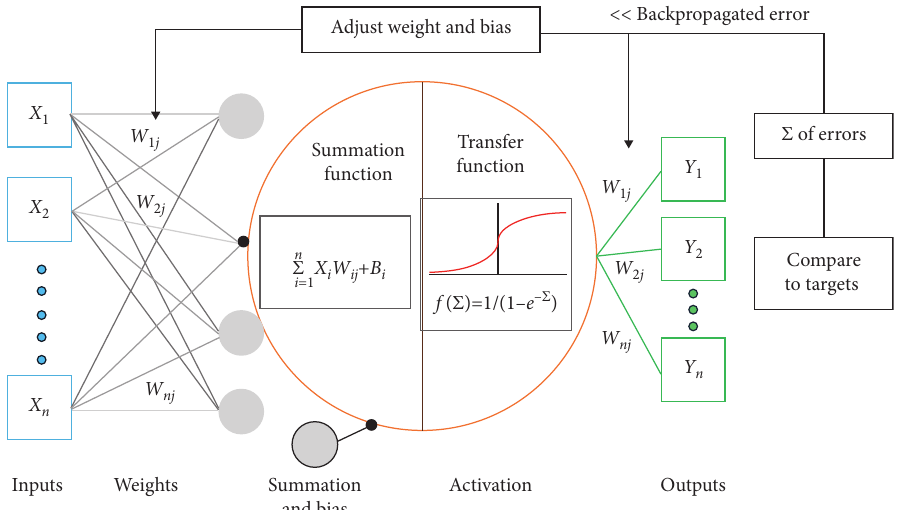
Figure 3: Structure of a single BP artificial neuron (hidden neuron) and mathematical